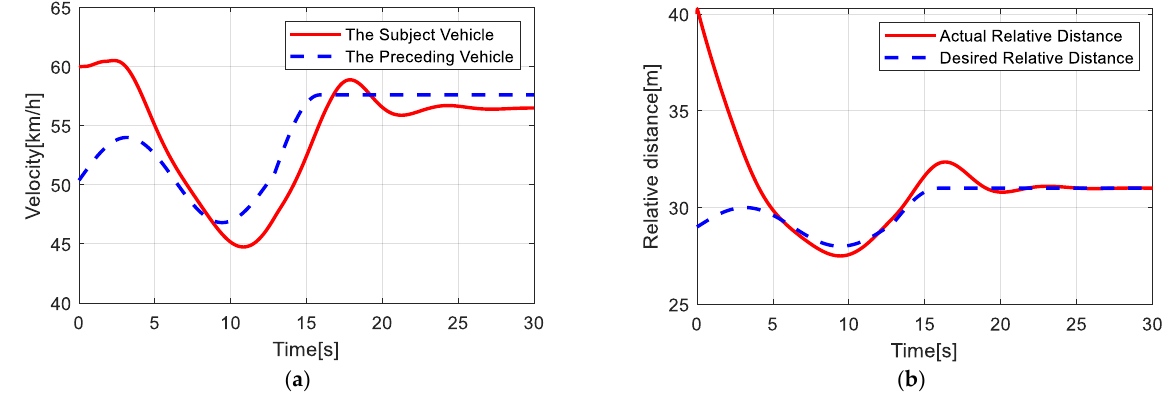
Figure 14. The simulation results of driving scenario 1: ( a ) the velocity of the subject vehicle and the cut-in vehicle; ( b ) the relative distance between vehicles.